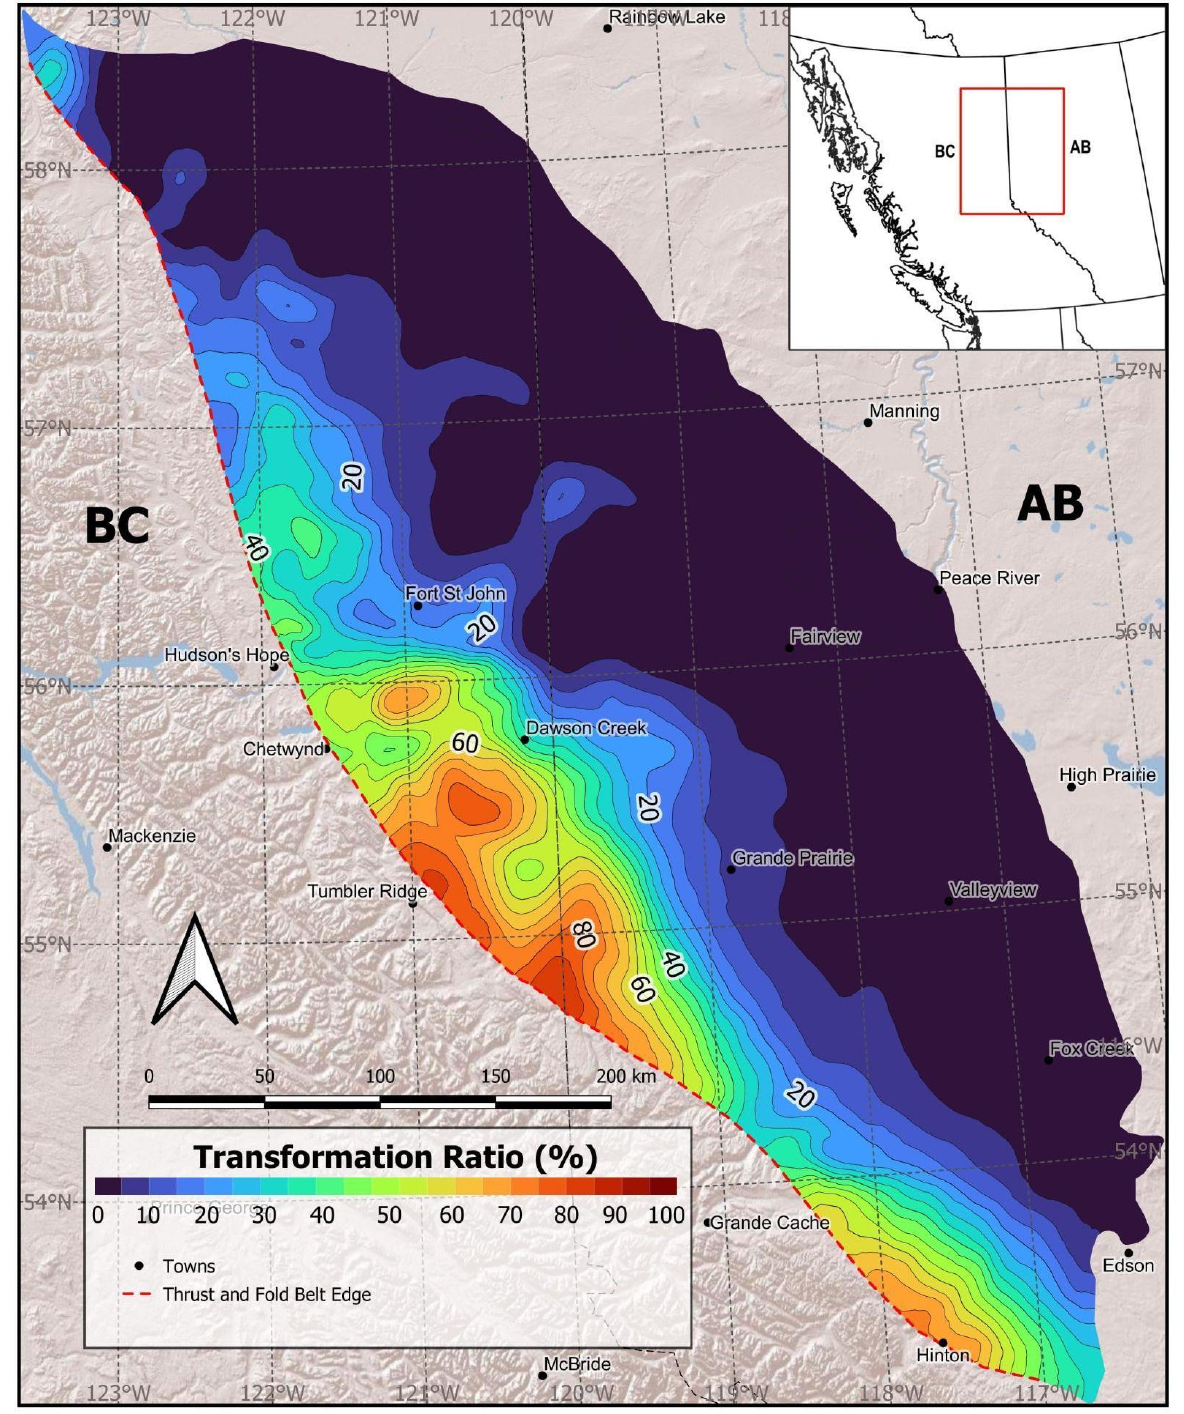
Figure 21. Kerogen transformation ratio in the Middle Montney Formation at 72 Ma. Due to the rapid foreland subsidence in the southwest, wet gas (LHCs) generation in the Montney Formation started throughout most of the southwest.